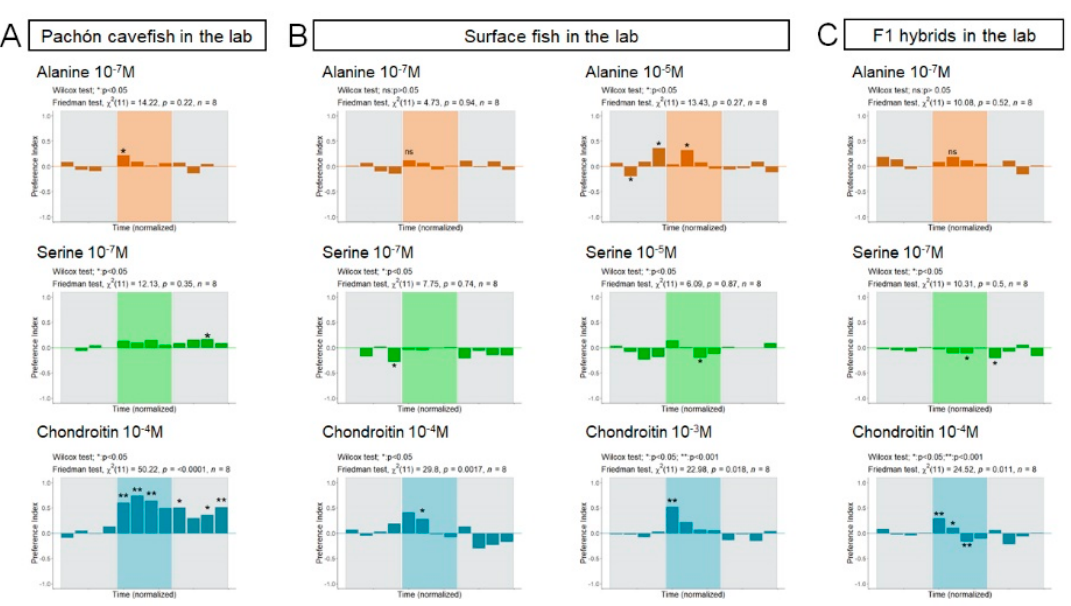
Figure 2. Testing olfactory skills in the laboratory; Olfactory responses of Pachón cavefish ( A ), Surface fish ( B ) and F1 hybrids ( C ) to the indicated odors at the indicated concentrations using the described olfactory setup in laboratory conditions ( n = 8 for each); The preference index (PI; positive values suggest attraction) is shown as a function of time. Time intervals corresponding to odor perfusion are shaded. Asterisks on graphs indicate significance as compared to no response (i.e., PI = zero) for a given time interval (Wilcoxon Mann-Whitney test). The results of Wilcoxon and Friedman tests to probe the significance of the response across time with repeated measures are also indicated.